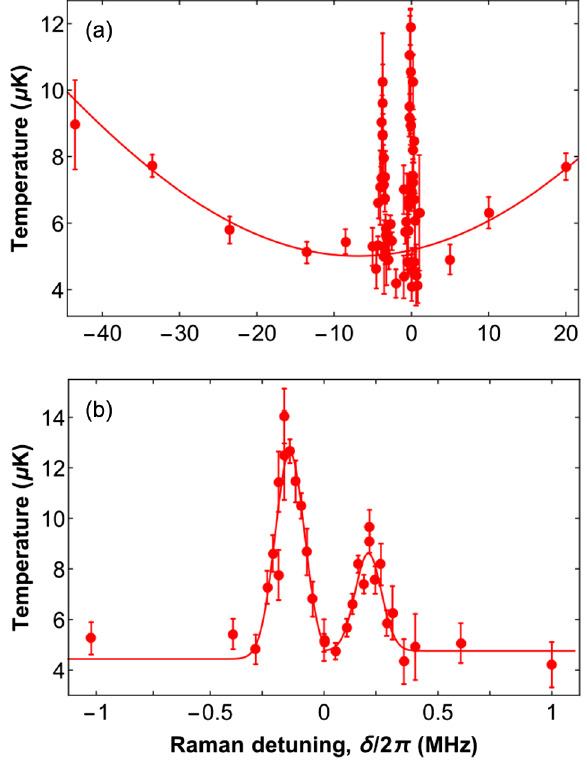
FIG. 3. Scan of δ in GMC. (a) Temperature versus δ , with I ¼ 3 . 2 I Δ ¼ 8 . 3 Γ for G ¼ 0 , F ¼ 1 . 0 and single-photon detuning The temperature is elevated near two Raman resonance con- ditions δ ¼ 0 (for G ¼ 1 , F ¼ 2 ) and δ = 2 π ¼ − 3 . 5 MHz (for G ¼ 1 , F ¼ 1 ). The solid line is a guide for the eye. (b) Enlarged scan near the resonance condition δ ¼ 0 , with I ¼ 3 . 2 I 0 and Δ ¼ 12 . 5 Γ . The solid lines are Gaussian